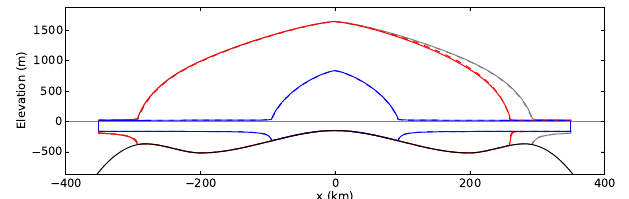
Figure 4. Bed topography of the three-dimensional channel setup, here shown in the scaled version with α = β = 0 . 5 (see Fig. 3 for a cross section along y = 0). Steady-state grounding-line po- sitions for simulations 3-D (continuous) and 3-D ref α = 1 ,β = 1 ,γ = 1 2 2 (dashed). Grey lines mark the position of the coastal sill and the bed depression, respectively. Output of the reference simulation is scaled by 0.5 in horizontal direction to allow for comparison of shapes between the two